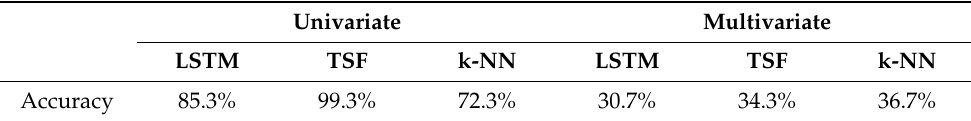
Table 13. ML Model Accuracy Comparison.